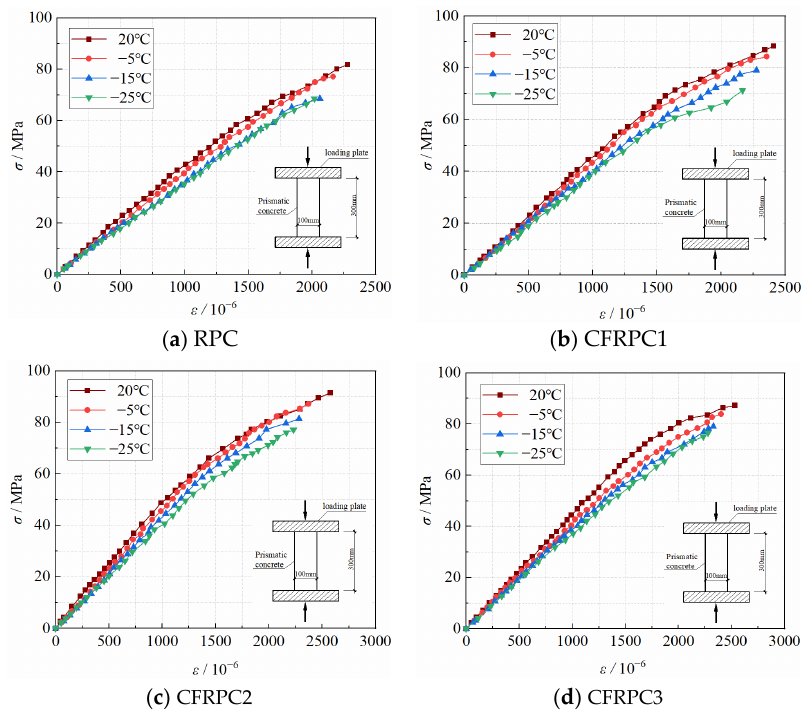
Figure 26. Stress–strain curves of CFRPC after different exposure temperatures.